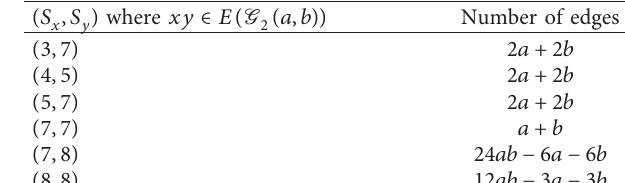
Table 3: The partition of edge set of graph G degrees of end vertices of each edge.